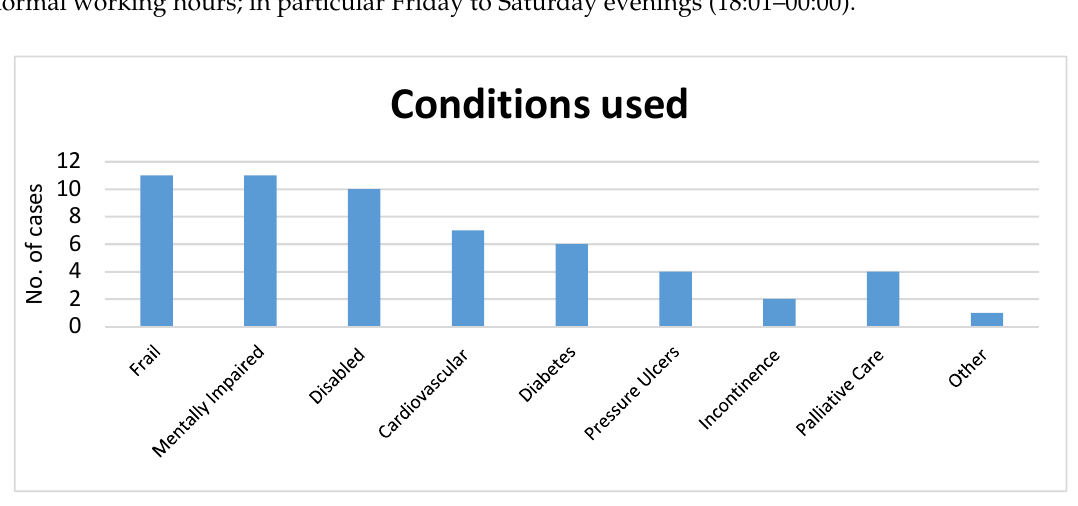
Figure 2. Conditions respondents reported using videoconferencing for.